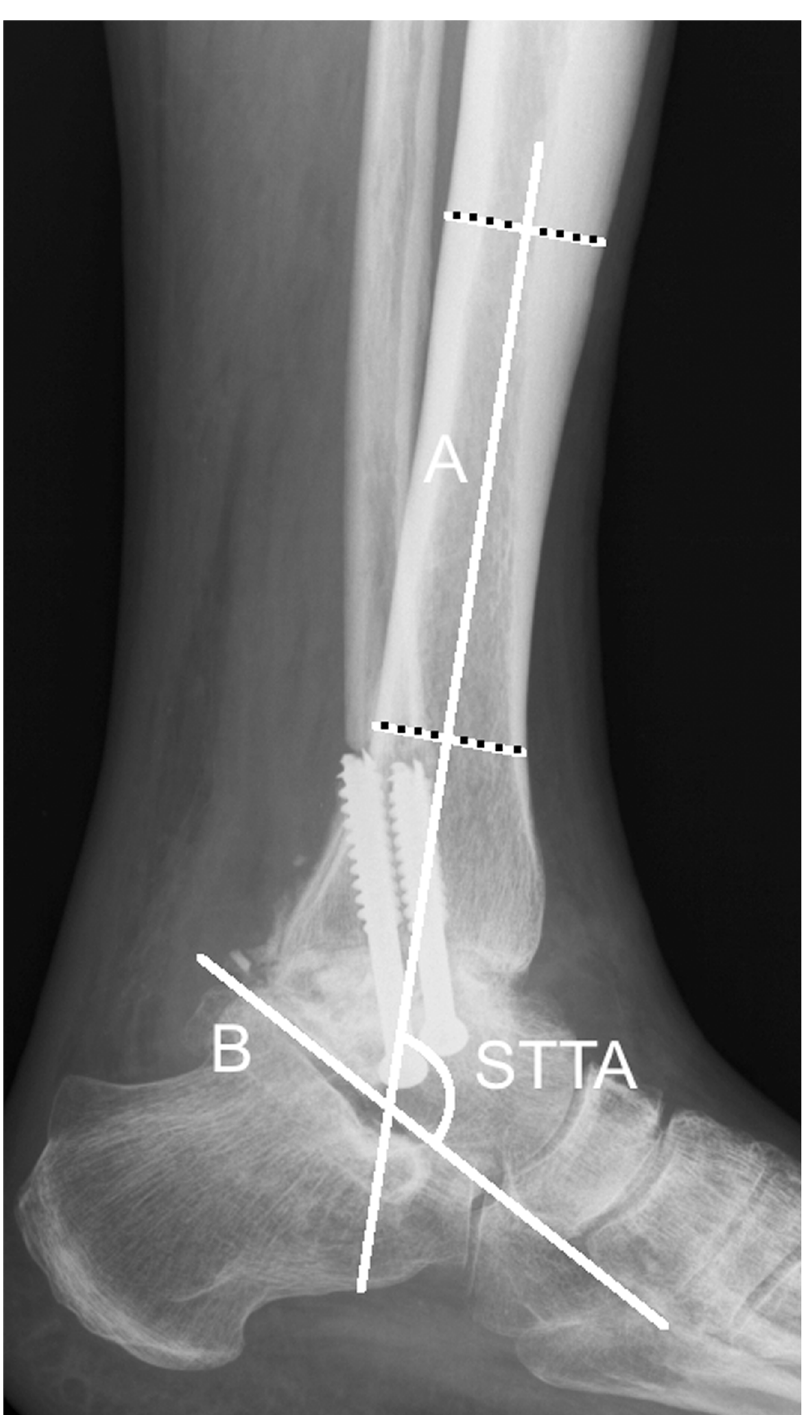
Fig 2. Lateral radiograph ankle arthrodesis. Lateral ankle radiograph with the measurement of the sagittal tibiotalar angle (STTA). The STTA is the angle between the the two axes A and B. A = longitudinal axis of the tibia, created by connecting two points in the middle of the proximal and the distal tibial shaft (according to method B). B = axis of the talus, defined by a line drawn from the inferior aspect of the posterior tubercule of the talus to the most inferior aspect of the talar